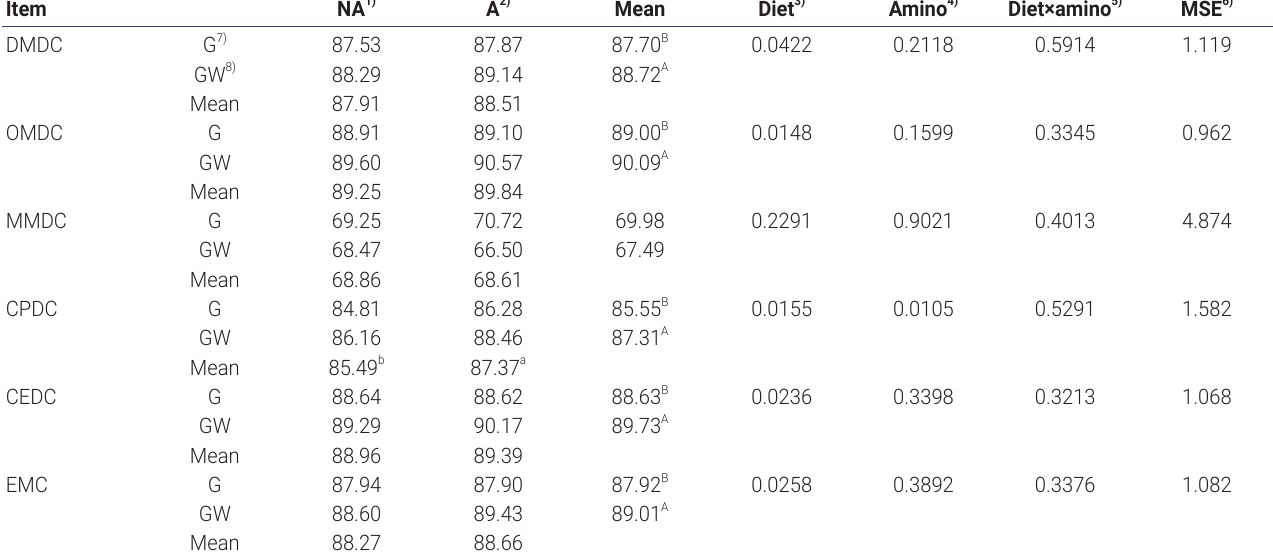
Table 6. Digestibility coeficients and energy metabolizability coefficient of piglets supplemented with L-glutamine + L-glutamic acid with or with - out whey powder